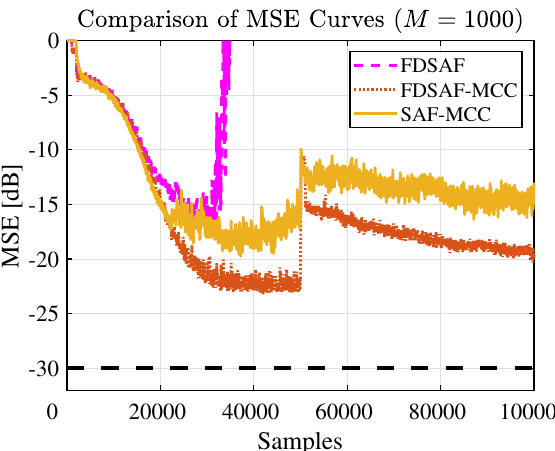
Figure 9. Experiment 2: MSE curves of FDSAF, FDSAF-MCC, and SAF-MCC under a sudden change.